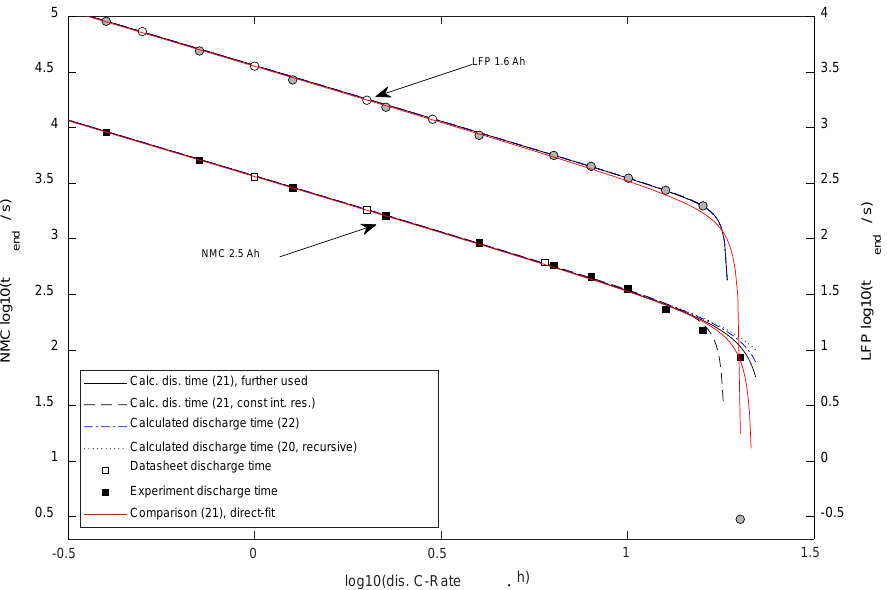
Figure 4. Discharge duration dependent on the discharge current (the typical Peukert plot). Two y-axes were used to avoid overlay of NMC and LFP results.